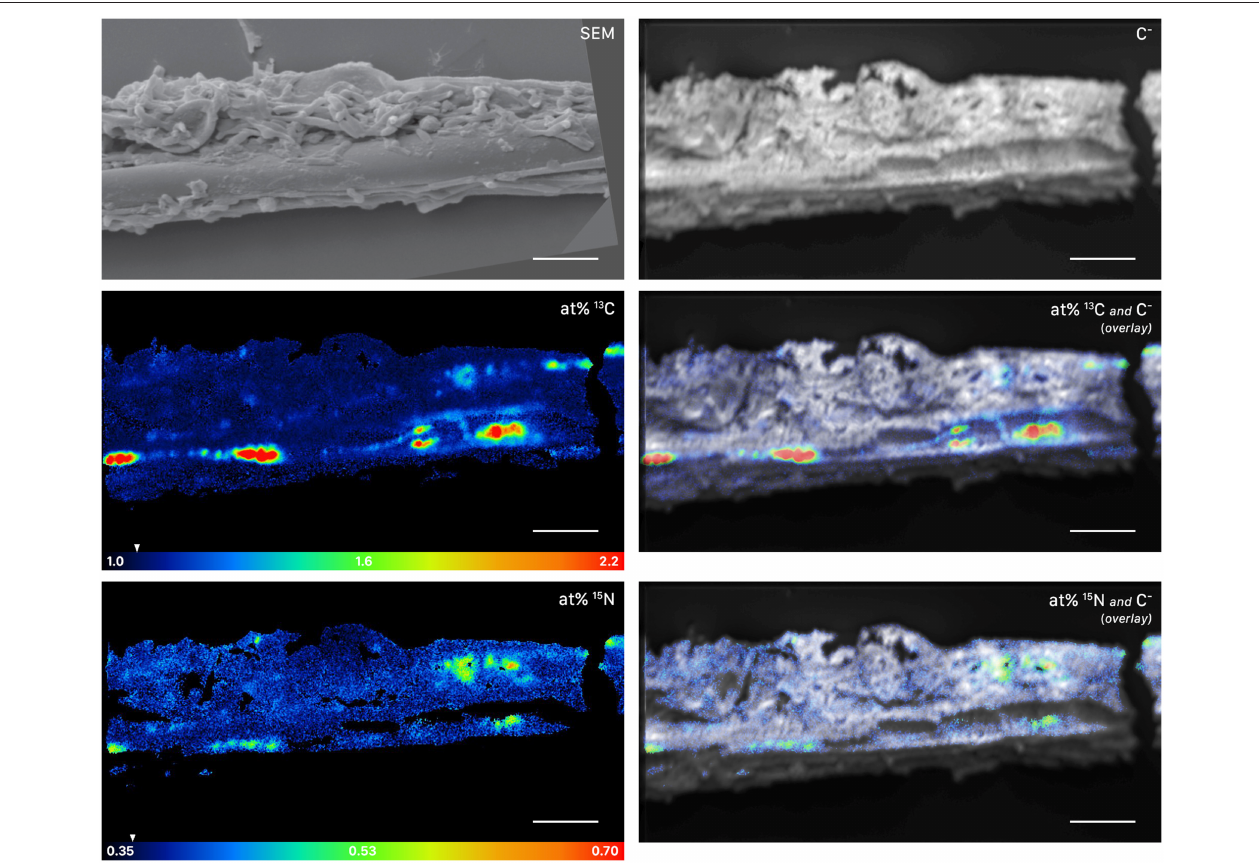
FIGURE 5 | NanoSIMS and SEM images of a root-distant fungal hypha extracted from a litter compartment of a dual-labeled plant box, depicting 13 C and 15 N labeled regions within the hypha. The SEM image shows the morphology of the sample prior to NanoSIMS measurement. NanoSIMS images were acquired at an erosion depth below the hyphal surface, visualizing the presence of isotopically enriched compounds inside the hypha. Isotopic label contents are displayed as atom%. The white arrows at the color-scales indicate the natural isotopic abundance values, determined on the unlabeled control (1.08 atom% 13 C and 0.37 atom% 15 N). The upper limit of the atom% 13 C scale is set to 2.2; however, maximum local values, extracted from individual cycles, range up to 3.6 atom% 13 C. Secondary ion signal intensity thresholds were set to 62 and 60 counts/(sec*pixel) for 12 C 13 C − and 12 C 15 N − , respectively. SEM, scanning electron microscopy image (secondary electrons); C − , accumulated 12 C − and 13 C − secondary ion signal intensity distribution images, indicating the morphology of the sample during NanoSIMS analysis; at% 13 C, carbon isotope composition image; at% 15 N, nitrogen isotope composition image. Overlay images are composites of the C − and isotope images. NanoSIMS images consist of accumulated z-stacks obtained from 19 consecutive scans (displayed in Animation S1 ). Scale bars, 5 µ